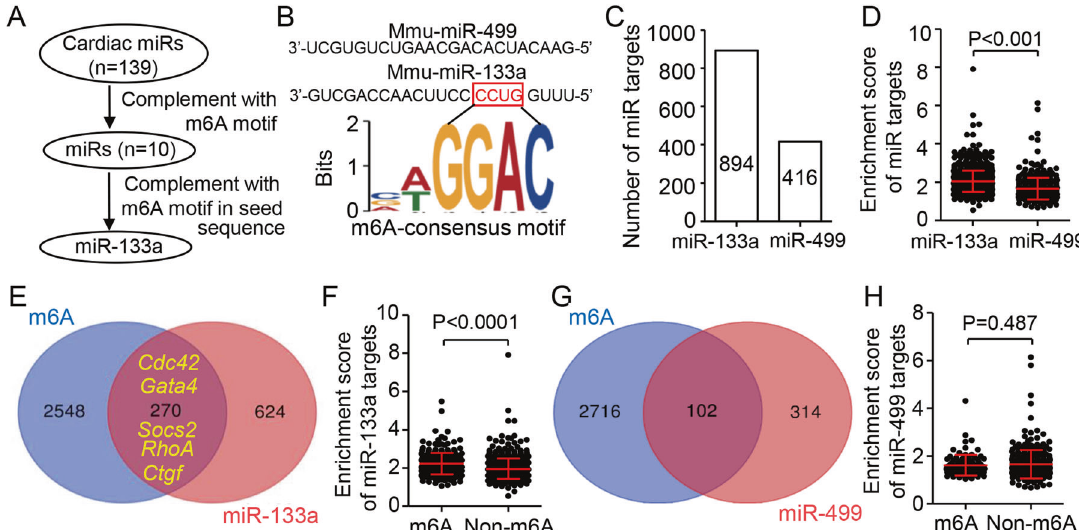
Fig. 1 m6A modi fi cation promotes cardiac miR-133a enrichment to its targets. A Schematic of screening cardiac miRNAs and identifying miR-133a targets with m6A modi fi cation. B m6A consensus motif “ GGACH ” was inversely complement to the seed region of miR-133a, but not to miR-499. C , D Comparison showing the number and enrichment score of miR-133a or miR-499 targets. The data are obtained from the RISCome RNA-sequencing (Ago2) pull-down on ventricular tissues of 8-week-old male FVB/N mice. E Venn diagram showing the overlap of m6A-modi fi ed genes and miR-133a target genes. F The difference of the enrichment score of miR-133a target genes with or without m6A modi fi cation. G Venn diagram showing the overlap of m6A-modi fi ed genes and miR-499 target genes. H Overall enrichment scores of miR-499 target genes with or without m6A modi fi cation. P values were calculated by unpaired two-tailed Student ’ s t test ( D , F , and H